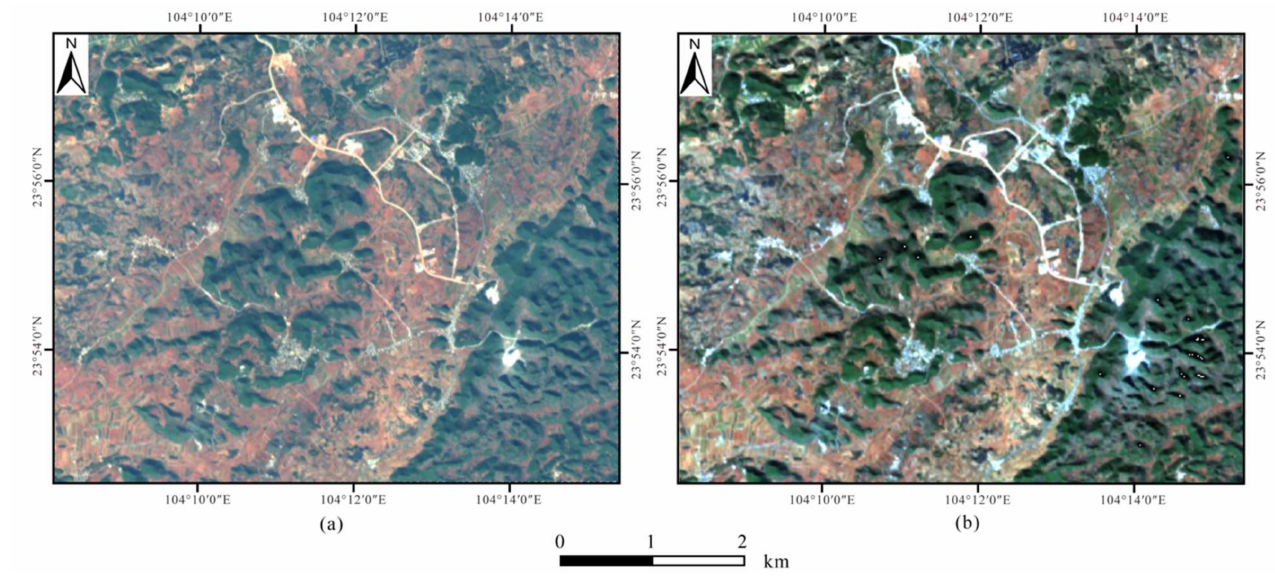
Figure 7. ( a ) Raw GF-5 hyperspectral image; ( b ) GF-5 image processed by radiometric calibration and FLAASH.